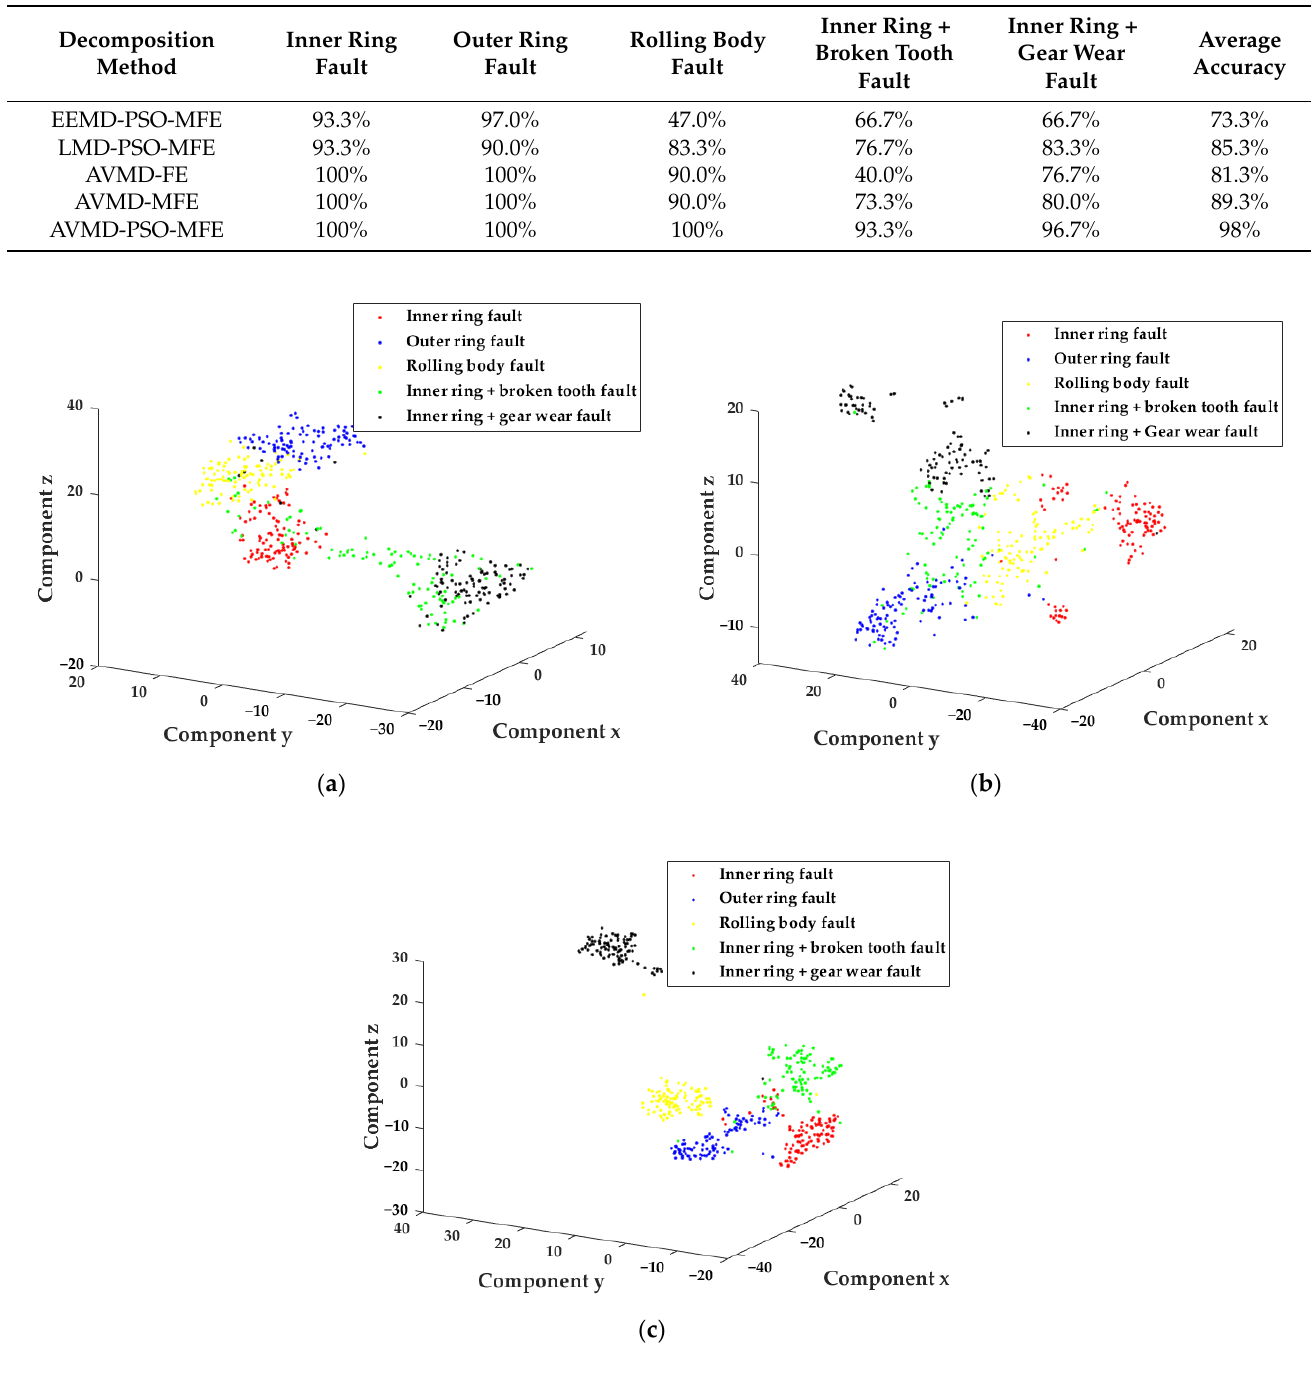
Figure 8. T-SNE dimensionality reduction visualization of FE, MFE and PSO-MFE feature sets. ( a ) AVMD-FE feature set. ( b ) AVMD-MFE feature set. ( c ) AVMD-PSO-MFE feature Table 6. Accuracy of different fault features.